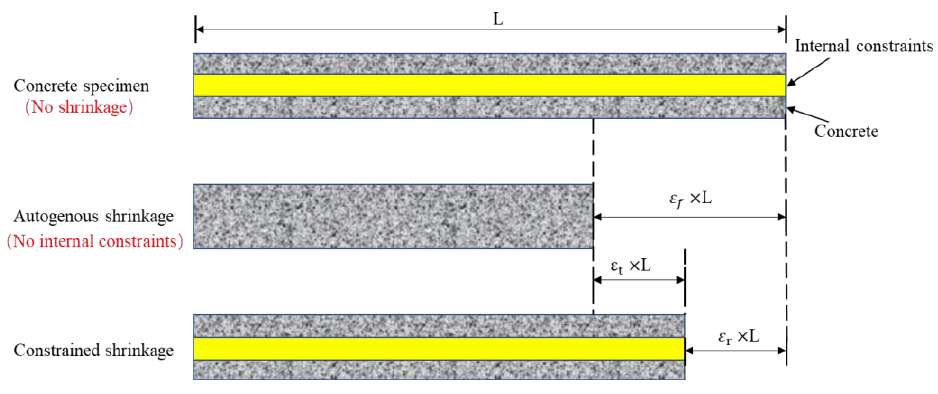
Figure 2. Schematic diagram of constrained shrinkage in concrete.